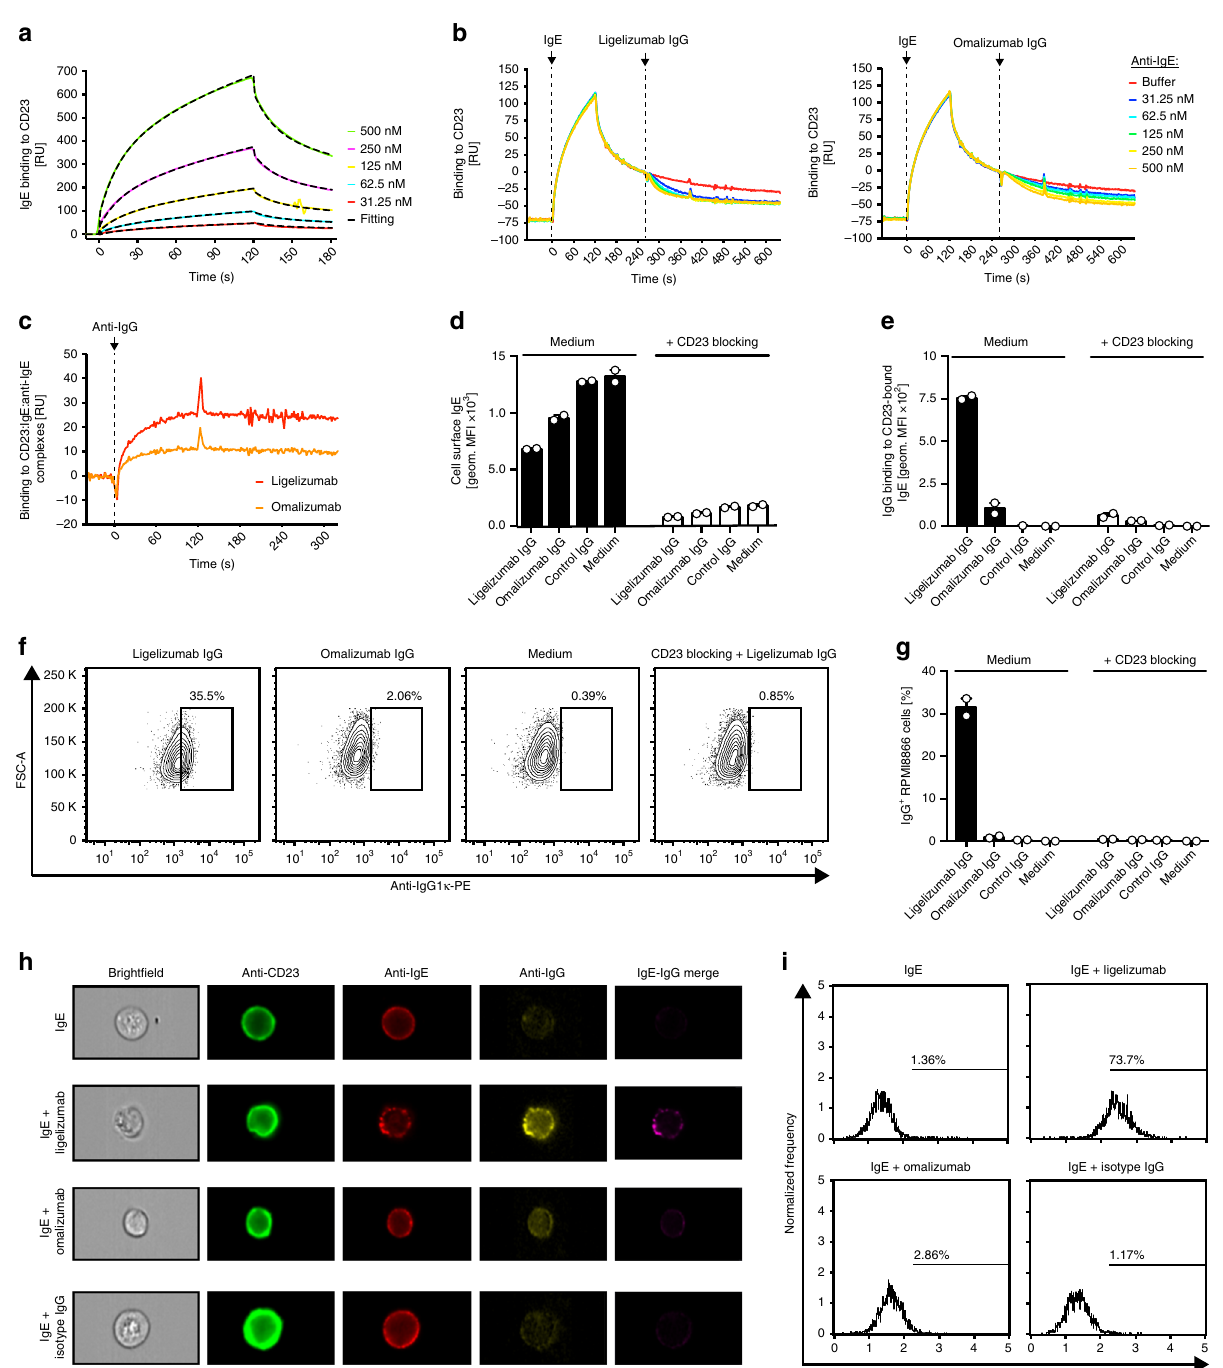
Fig. 4 Binding of CD23:IgE complexes by ligelizumab or omalizumab. a Association and dissociation of IgE to immobilized human recombinant CD23 by SPR. Each color refers to an individual measurement cycle. Curves were fi tted (black dashed lines) using a two-state reaction binding model. b Binding of ligelizumab and omalizumab IgG to CD23 pre-complexed human recombinant IgE was measured by SPR. c Binding of polyclonal anti-IgG to CD23:IgE:anti- IgE complexes was assessed by SPR. d Flow cytometric quanti fi cation of IgE ( d ) and IgG ( e ) surface levels on CD23-expressing RPMI8866 cells after treatment with ligelizumab, omalizumab or isotype IgG with or without blocking of CD23 prior to IgE sensitization (data for technical duplicates are displayed as mean ± SEM). Representative fl ow cytometry plots ( f ) and quanti fi cation of IgG-positive RPMI8866 cell frequencies ( g ) after treatment with ligelizumab or omalizumab with or without blocking of CD23 prior to IgE sensitization (data for technical duplicates are displayed as mean ± SEM). Representative image stream fl ow cytometry pictures for CD23-, IgE- and IgG staining ( h ) and co-localization analysis for IgE- and IgG staining ( i ) of IgE- sensitized RPMI8866 cells after treatment with ligelizumab, omalizumab or isotype IgG. Source data are provided as Source Data fi